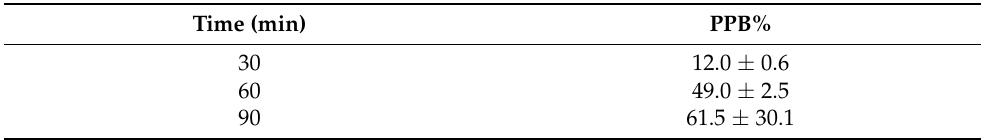
Table 4. Plasma protein binding percentage (PPB%) for complex C2 . Values are expressed as means ± SD, n = 3.